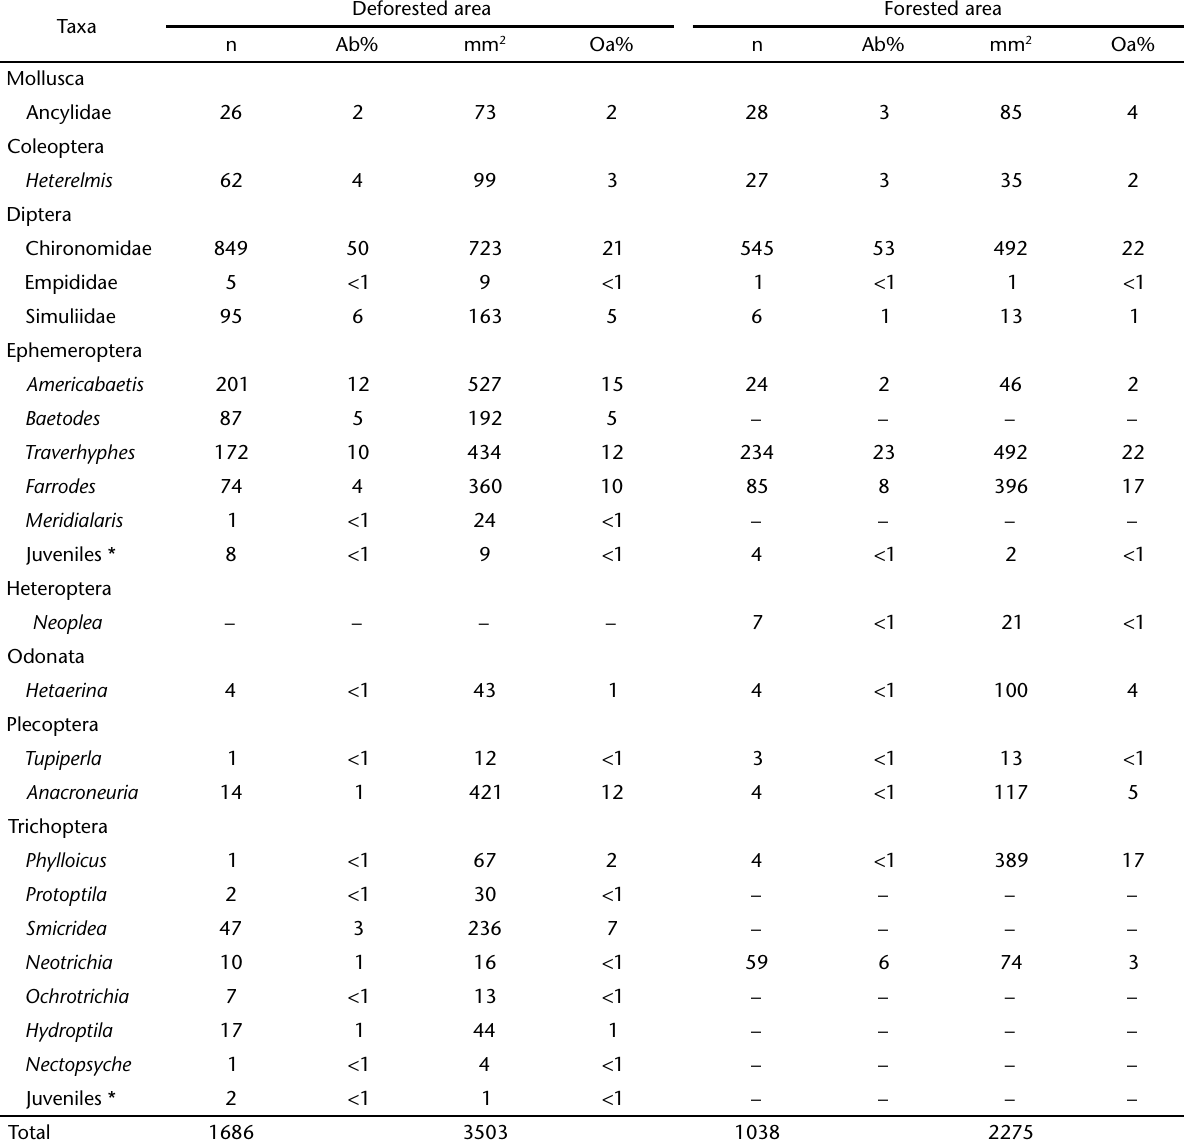
Table II. Macroinvertebrates sampled in leaf-bags incubated in two areas of the Ribeirão da Quinta stream during the dry season (July 2004). Absolute (n) and relative (Ab%) abundance, absolute (mm 2 ) and relative (Oa%) occupied area.